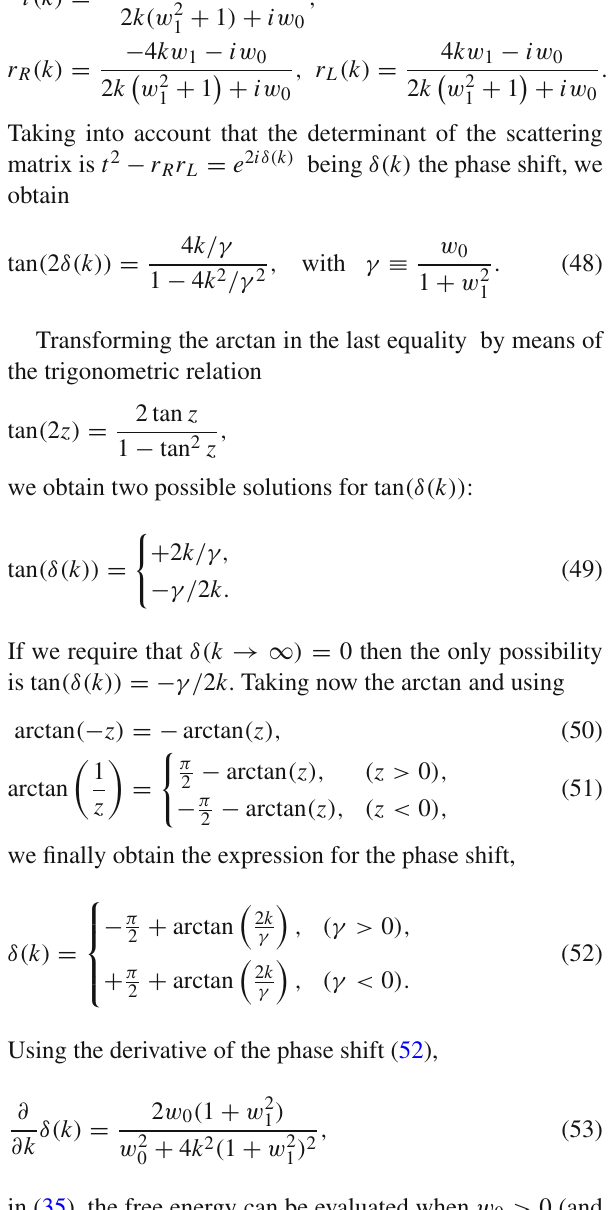
Fig. 2 Temperature dependent part of the free energy (54), for a single δ – δ (cid:2) -potential as a function of T for the potential V δδ (cid:2) and the configu-